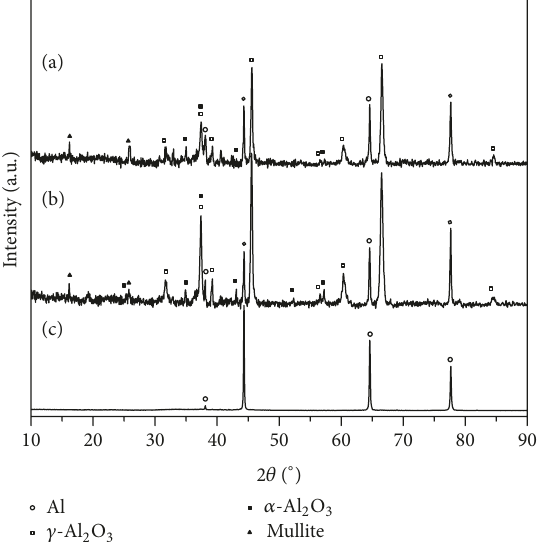
Figure 12: XRD patterns of coatings deposited at AC1 using a Na 2 SiO 3 +NaOH electrolyte and A356 alloy substrate for (a) MAO and (b) SMAO and (c) A356 alloy